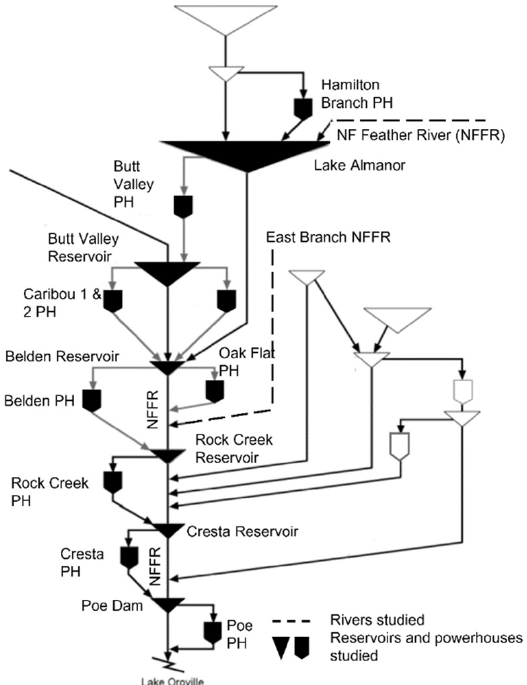
Figure 2. Schematic diagram of the hydropower system in this study from the Upper North Fork Feather River Hydroelectric Project (FERC 2105).